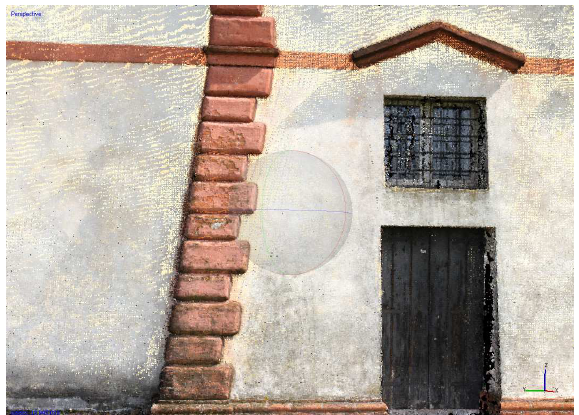
Figure 12. A detail of the points cloud of M3